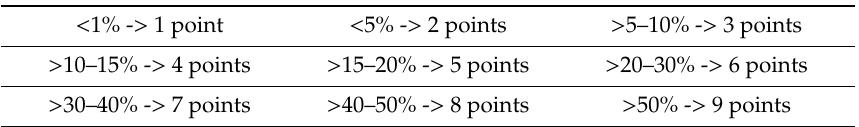
Table 9. Conversion of the average percent di ff erence in the number of respondents rating each criterion as high and very high between two criteria, to the 1–9 scale using the analytical hierarchical process to construct the pair-wise comparison reciprocal